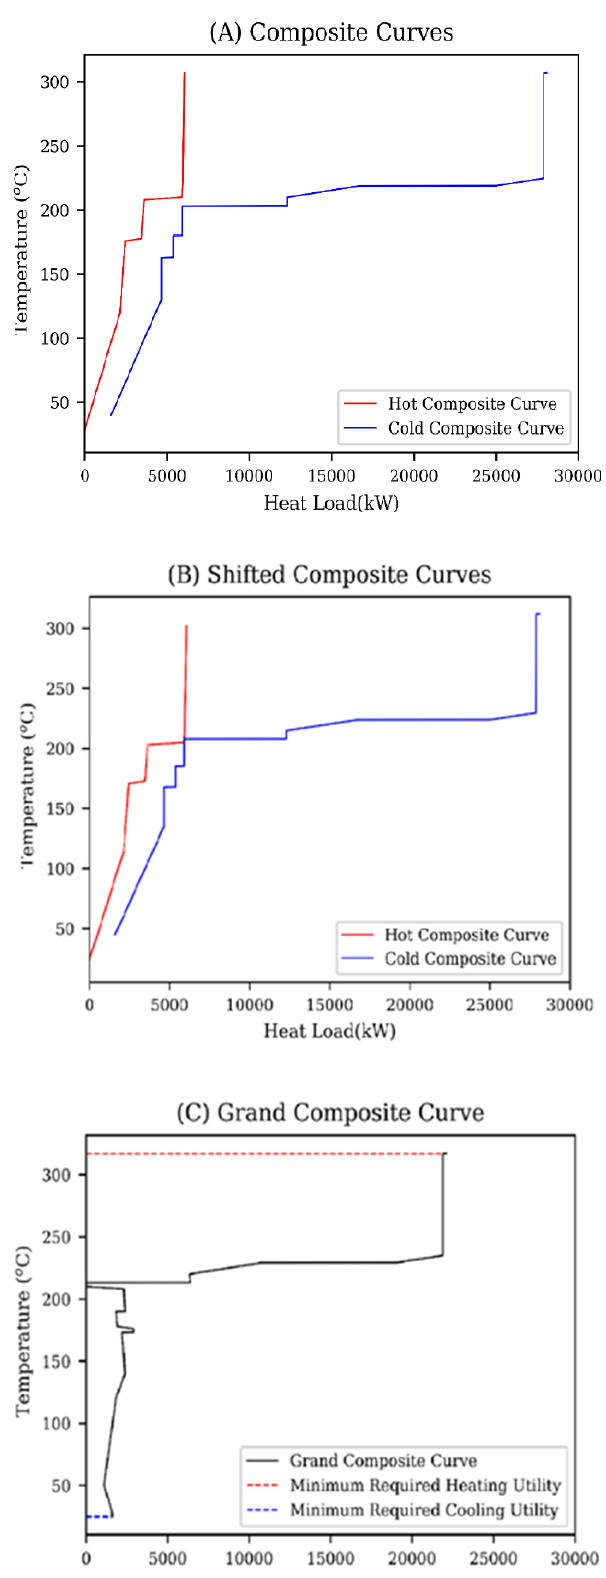
Figure 8. Heat integration curves ( A ) cold and hot composite curves showing ∆ T min and the process pinch temperature. ( B ) composite curves shifted by ± 5 K. ( C ) grand composite curve, showing the minimum required heating utility (Q Hmin ) and the minimum required cooling utility (Q Cmin ).